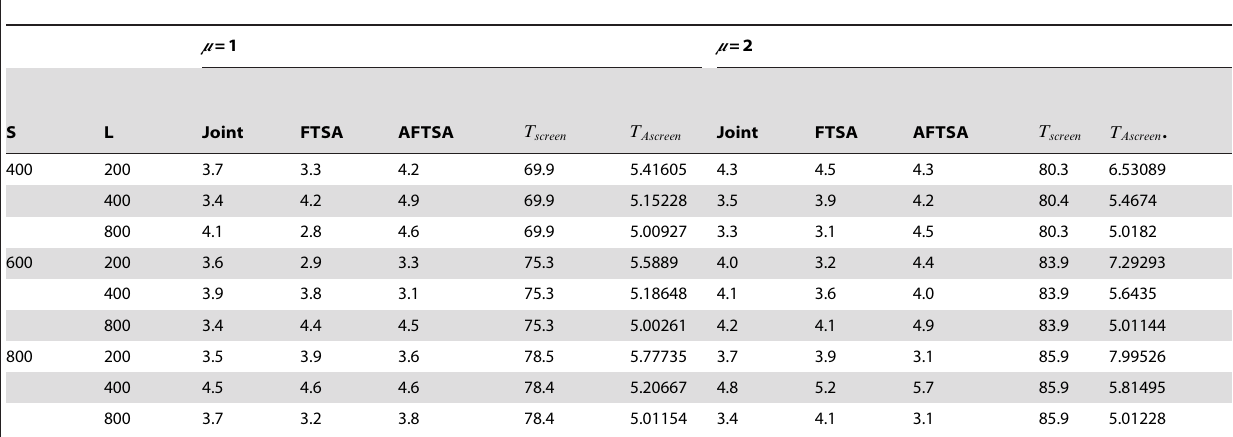
Table 2. Type I error rates (in percentage) of the five tests based on simulation set